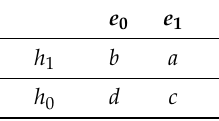
Table 1. The numbers of four types of examples for confirmation measures.